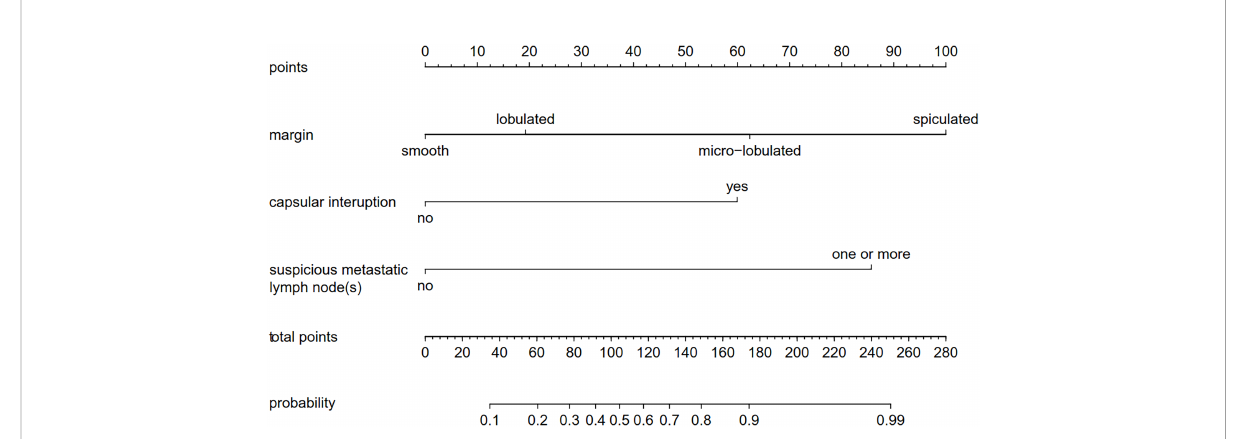
FIGURE 2 A nomogram forecasting the risk ofCLNMfor patients with MTC. The value of each ofthese variables was proportionally assigned a scorebased on the point scale. Subsequently, a total scorecould be obtained by summing up eachsubject ’ s score and identifying it onthe lower total point scale. The probability of CLNMin eachpatient can fi nally be determined. CLNM, cervical lymph node metastasis; MTC,medullary thyroid